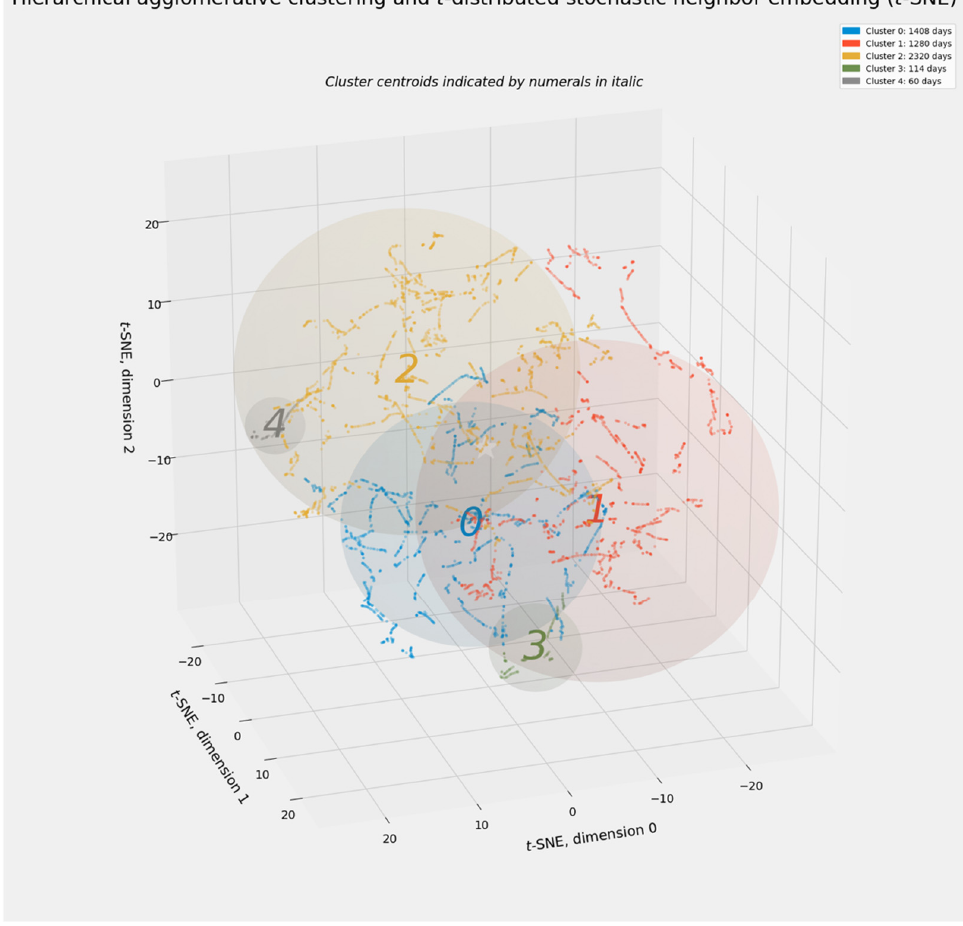
Figure 11. Hierarchical agglomerative clustering of commodity markets—A t -SNE manifold.